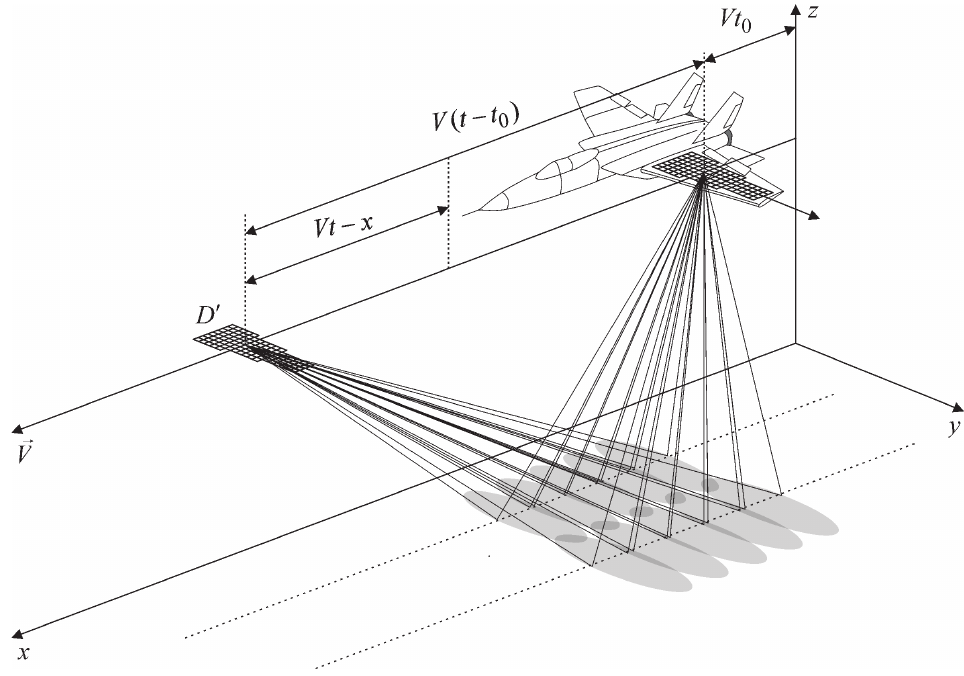
Figure 2. New mode of high resolution and wide-swath surface sensing.